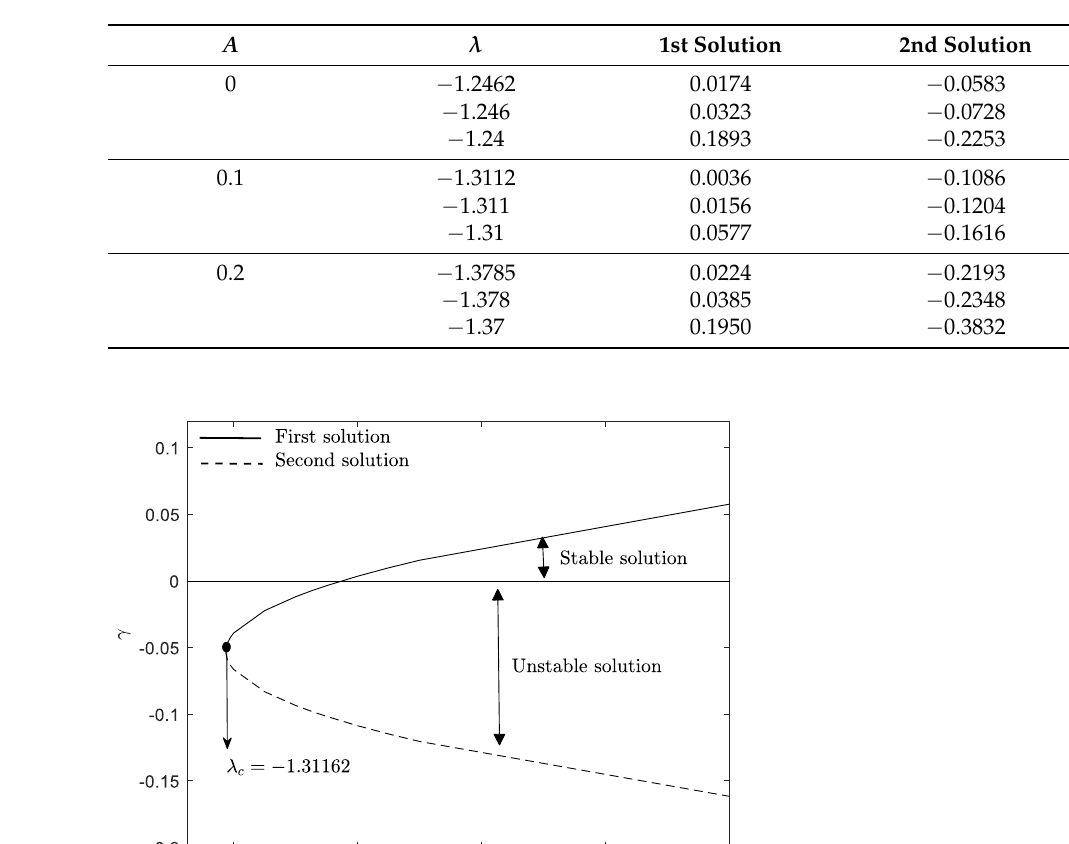
Figure 8. ( a ) with  ; ( b )    for various Rd Figure 8. ( a ) Nu x Re − 1/2 x with λ ; ( b ) θ ( η ) for various Rd . Table 4. Smallest eigenvalues  for selected A and  when Table 4. Smallest eigenvalues γ for selected A and λ when ϕ 1 = ϕ 2 = 0.01, Rd = 0.1, K = 1 and n = 0.5.